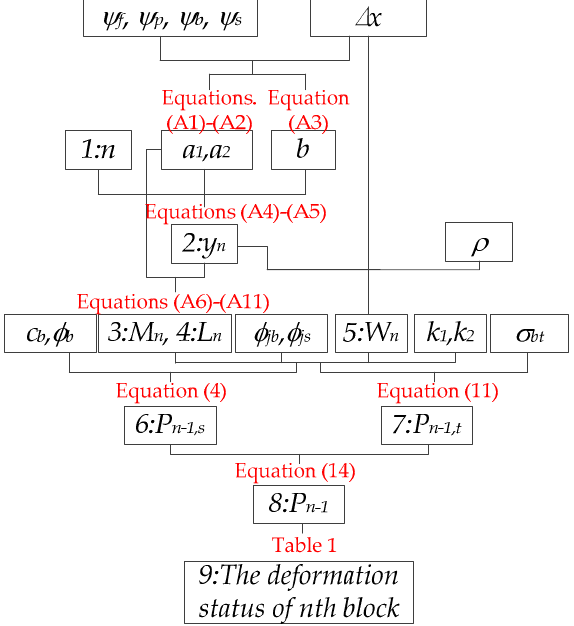
Figure 5. The flow chart to use the presented limit equilibrium method in sheet.